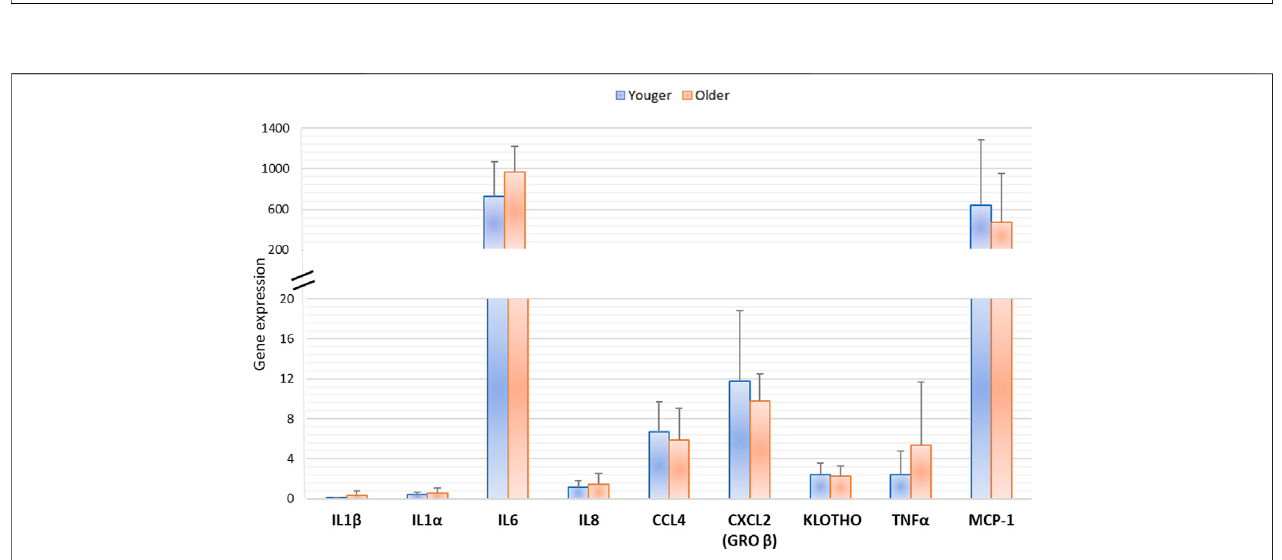
FIGURE10| GeneexpressionofMSCsderivedfromclottedBMAsfromyoungerandolderdonorsmeasuredbysemiquantitativePCRforKlothoandsenescence- associated gene expression (IL1 β , IL1 α , IL6, IL8, CCL4, CXCL2, TNF α , and MCP-1).